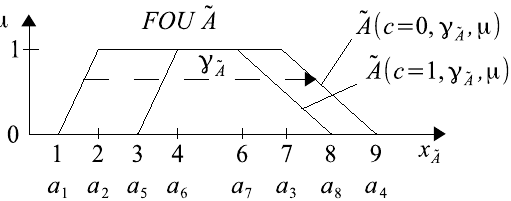
Figure 15. FOU ˜ A or projection of ˜ A ( c , γ ˜